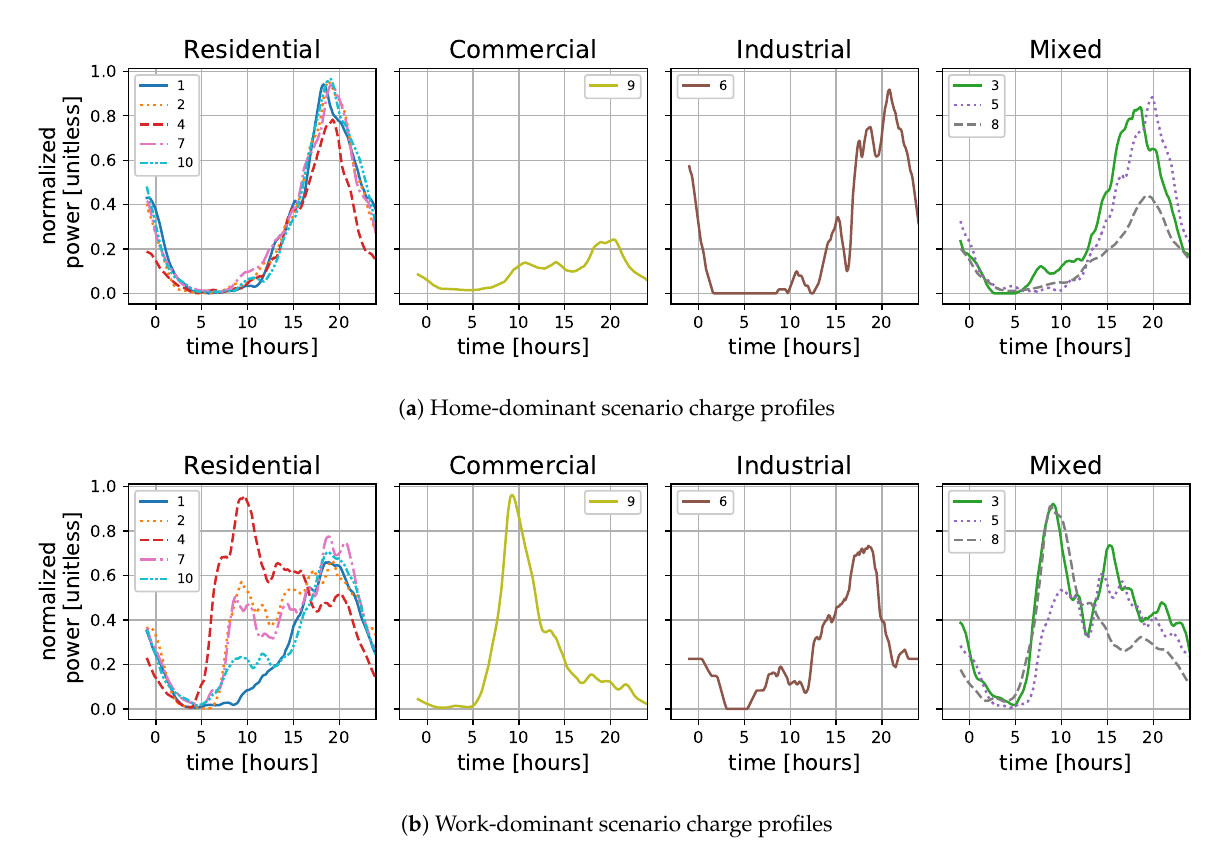
Figure 6. The EV charging demand profile changed dramatically from the home to the work-dominant scenarios when the feeder supported commercial loads. ( a ) The home-dominant scenario produced similar profiles for feeders designated as residential, industrial, and mixed. The commercial feeder had a significant amount of charging that occurred during the day. ( b ). In the work-dominant charging case, some profiles did not change, but others with substantial commercial loads had a shift in the peak which moved from the evening to the middle of the